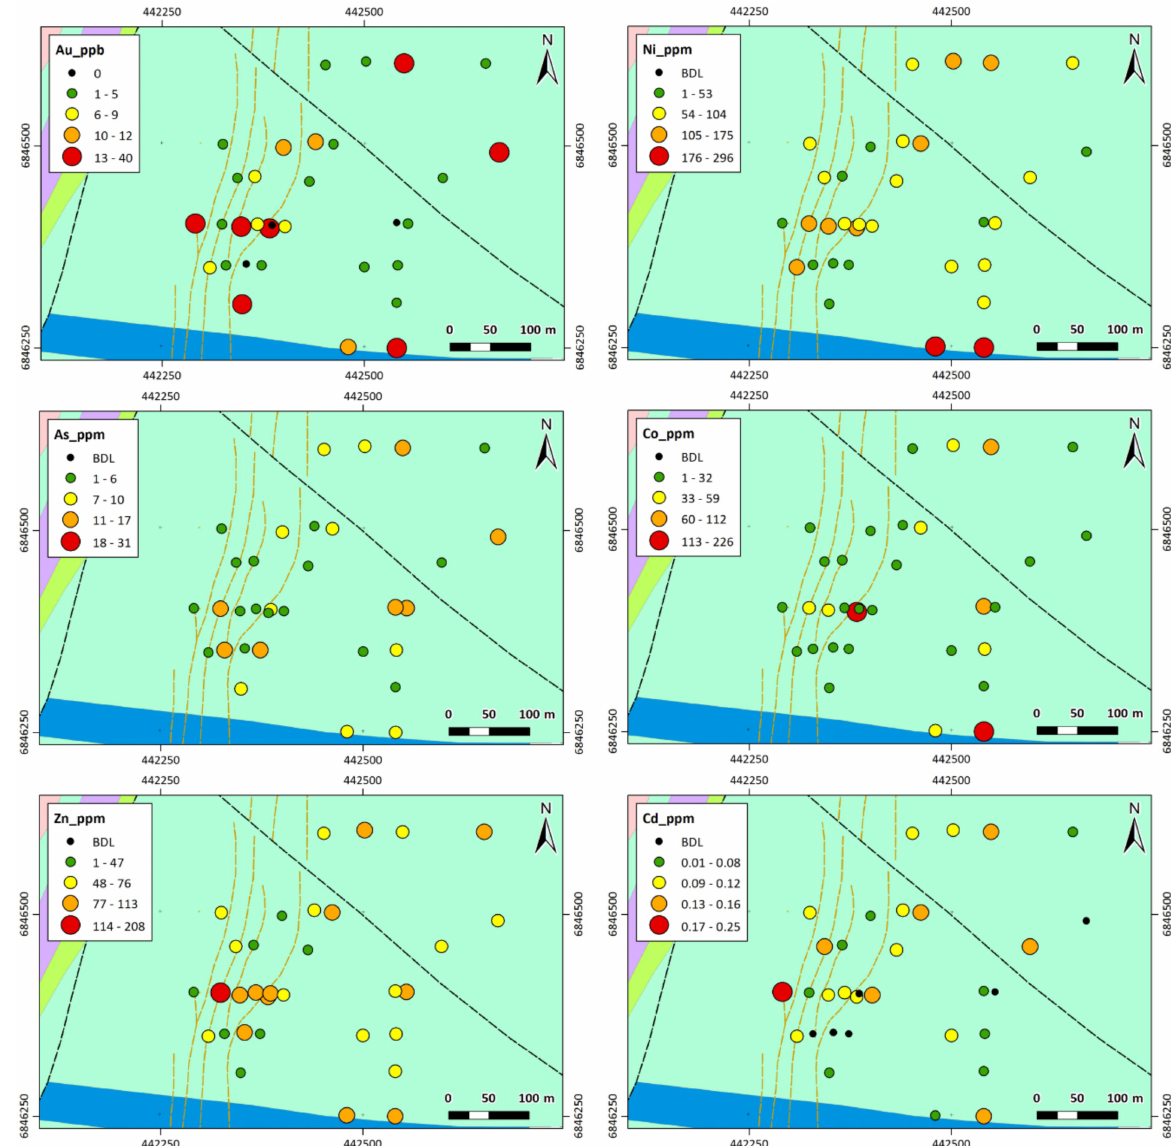
Figure 18. Bubble plot of Fe-rich redox samples collected from 32 RC drill holes (Figure 2) showing elevated contents of Au, As, Ni, Co, Zn, and Cd over the mineralization and the